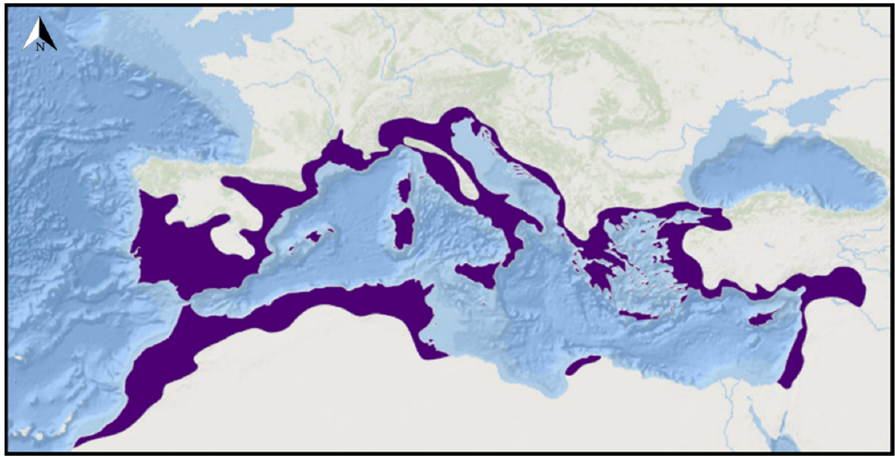
Figure 2. Distribution of the olive orchards in the Mediterranean region according to [9] .